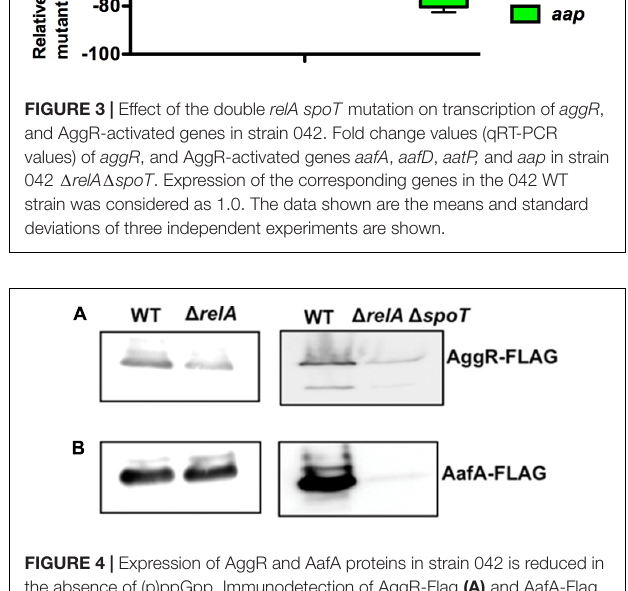
FIGURE 4 | Expression of AggR and AafA proteins in strain 042 is reduced in the absence of (p)ppGpp. Immunodetection of AggR-Flag (A) and AafA-Flag (B) proteins in total cell extracts from cultures from strain 042 and its isogenic mutants (cid:49) relA and (cid:49) relA (cid:49) spoT . Experiments were repeated three times. A representative experiment is